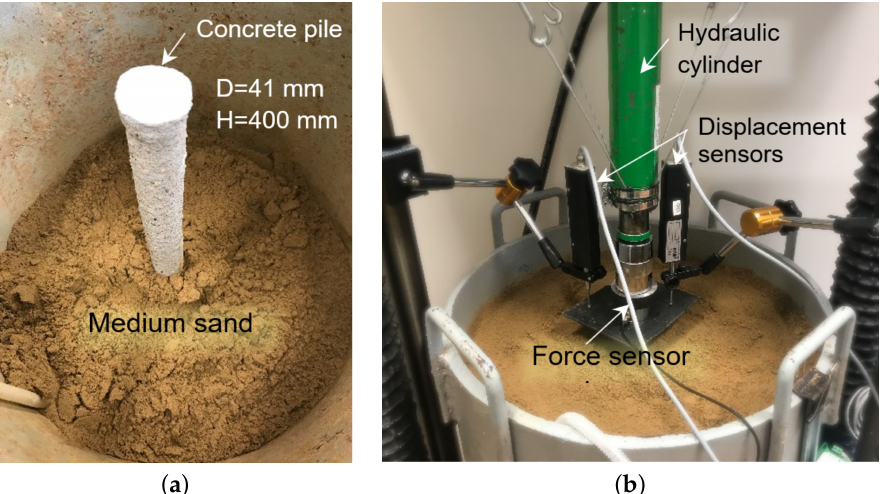
Figure 12. Test rig for pile bearing capacity ( a ) compaction of soil around the pile, ( b ) foundation pile prepared for